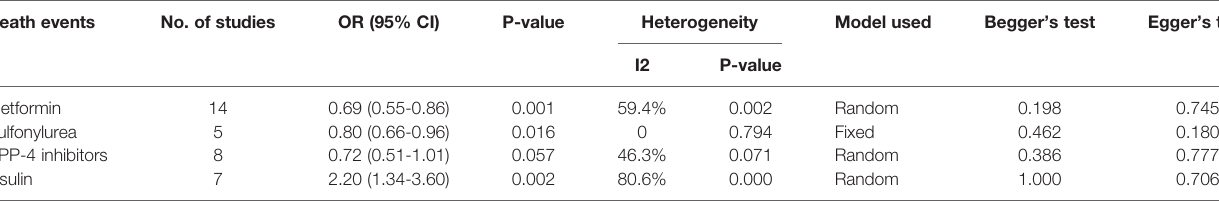
TABLE 2 | The result of publication